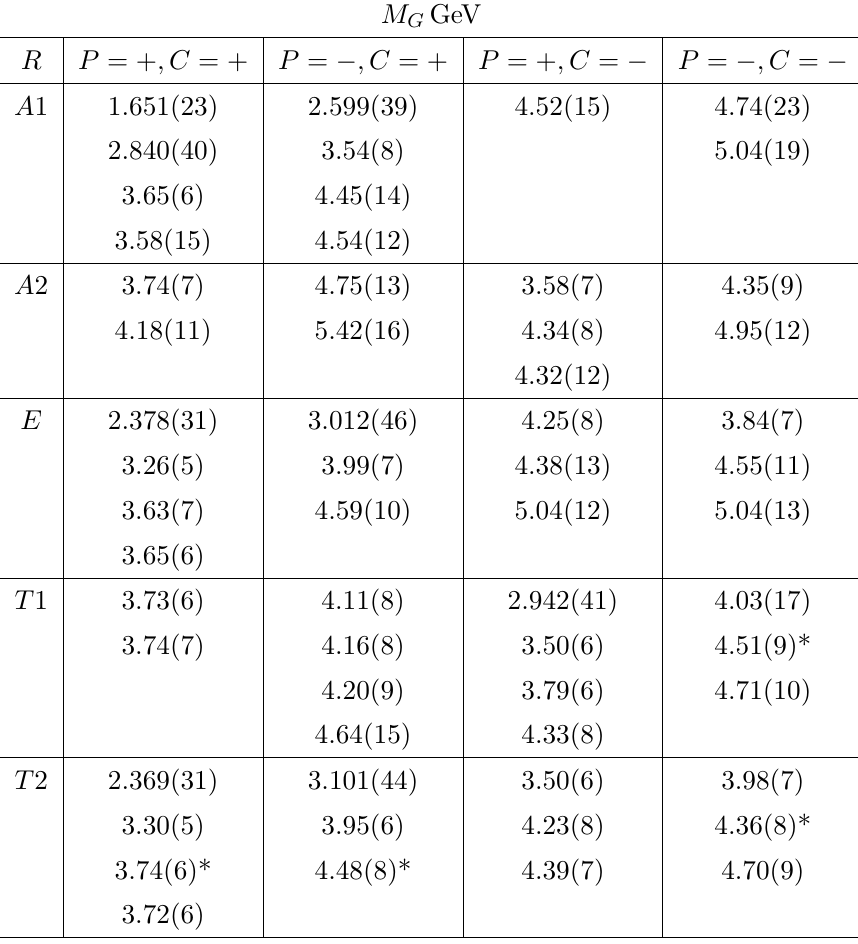
Table 15 . Continuum glueball masses in GeV units using the value r 0 = 472(5) fm from [21] to set the scale. Errors are statistical